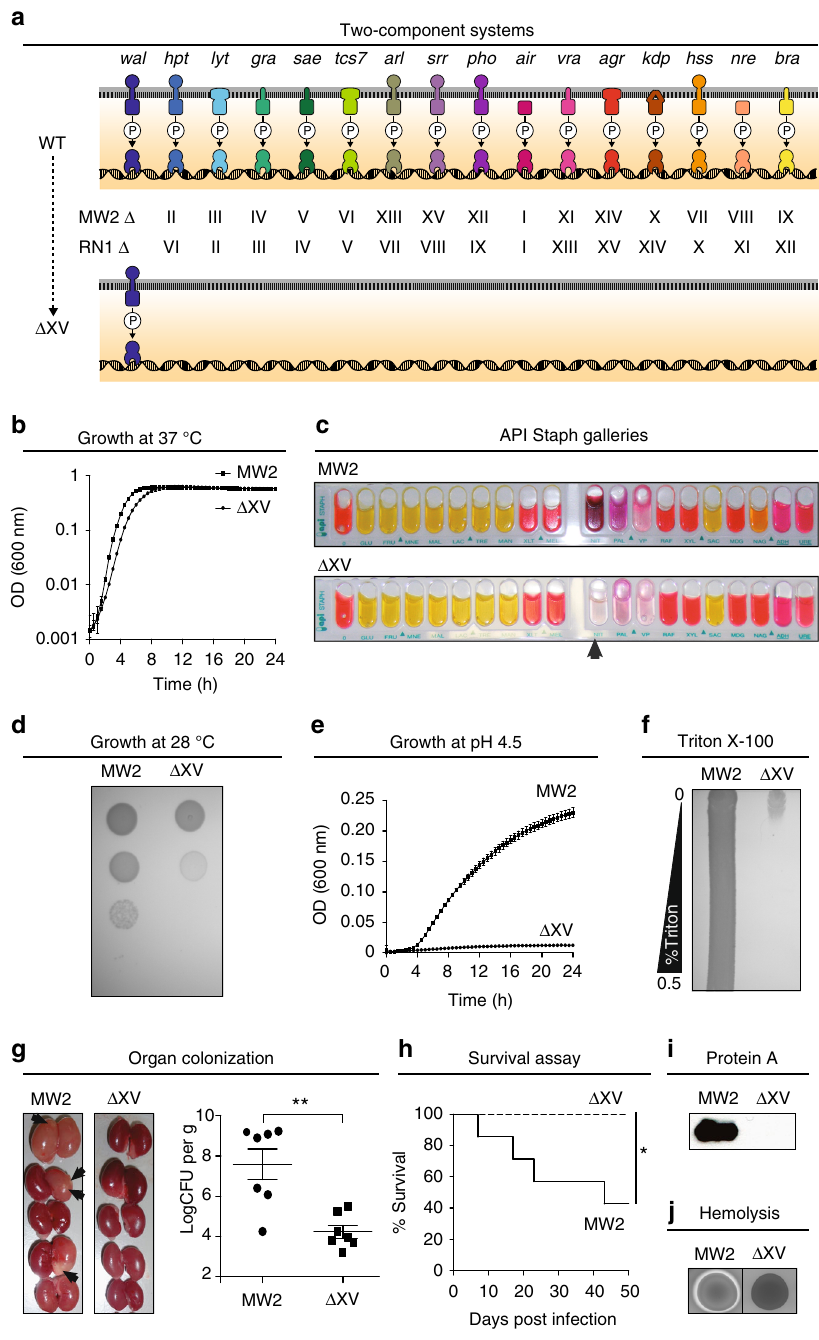
Fig. 2 Phenotypic characterization of a S. aureus derivative only harboring the WalRK TCS. a Scheme of the TCSs present in wild-type (MW2